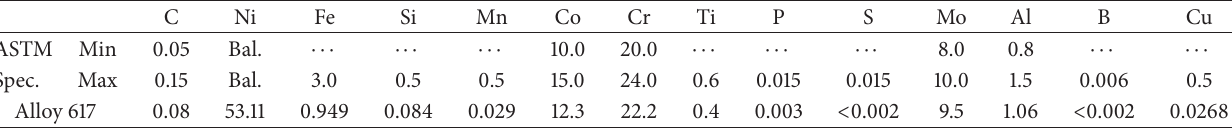
Table 1: The chemical composition of Alloy 617 plate used in this study